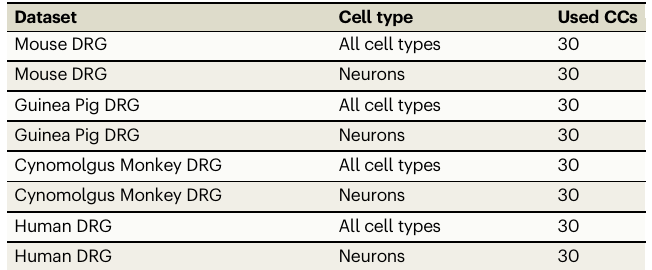
Table 1 | Canonical correlation (CC) dimensions used in Seurat integration analyses, by cell type and species